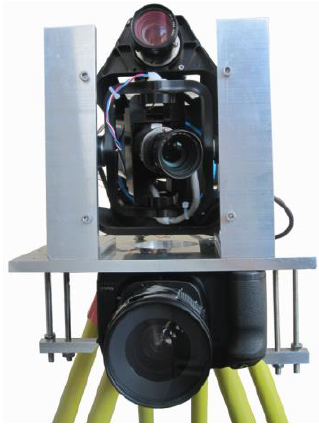
Figure 3. Experimental set-up